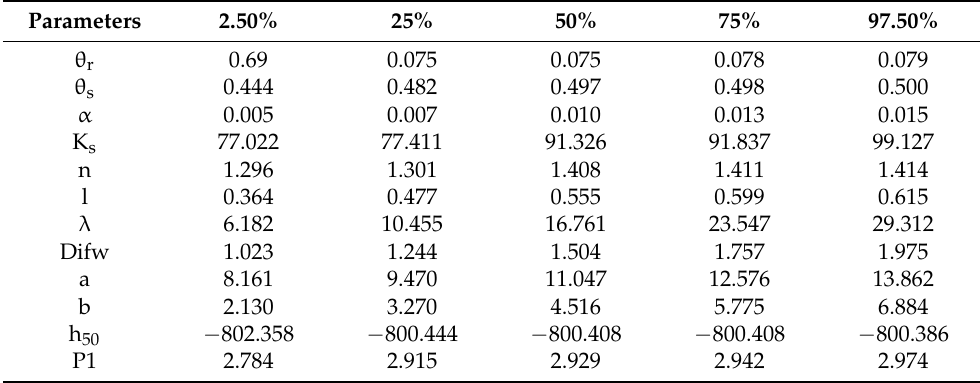
Table 7. Quantiles of the posterior distribution of the model parameters.